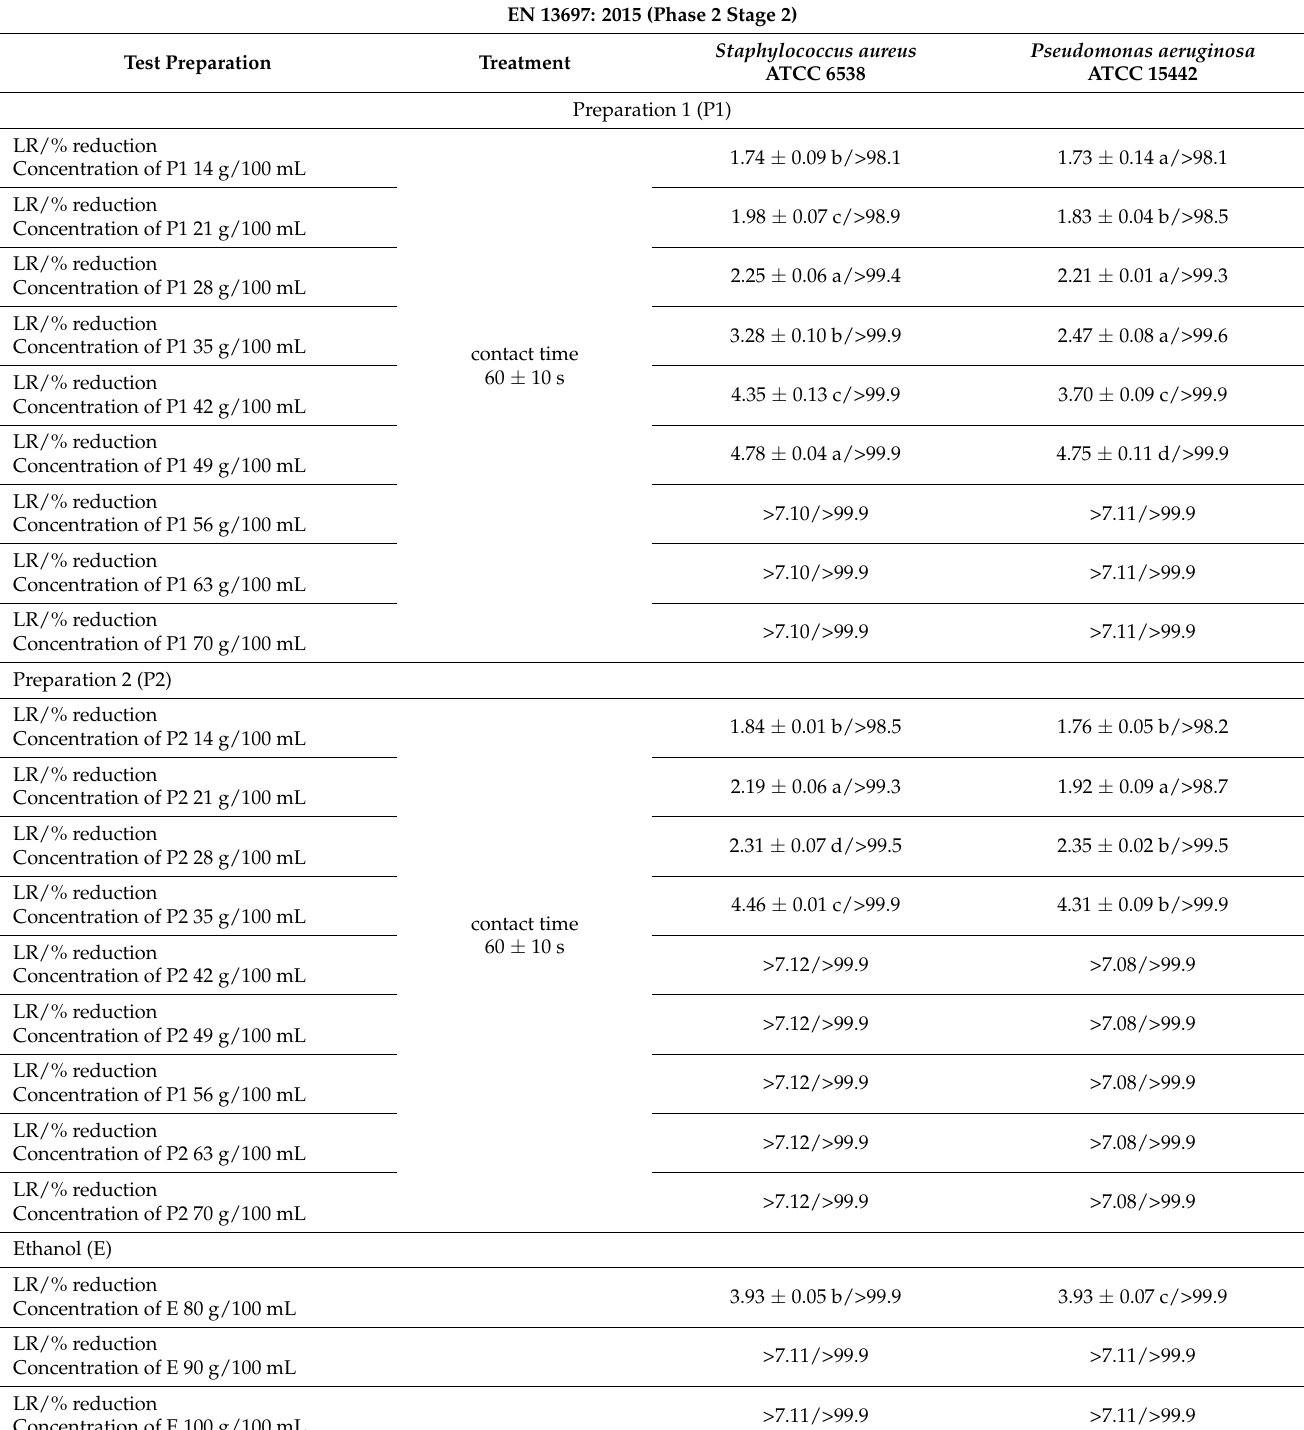
Table 4. The results of surface disinfection tests of preparations 1 and 2 by standard EN